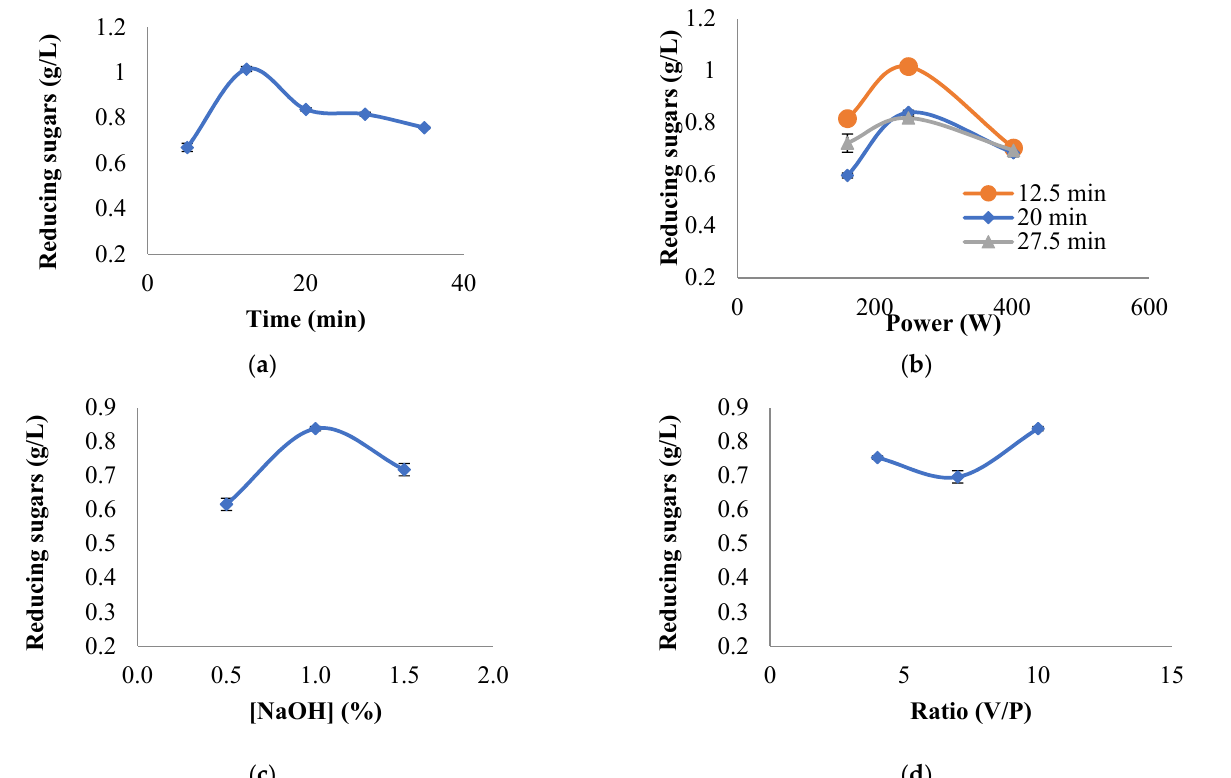
Figure 2. Influence of all studied parameters on reducing sugars: ( a ) time, ( b ) power, ( c ) concentration of NaOH, ( d ) volume NaOH/algae mass ratio.